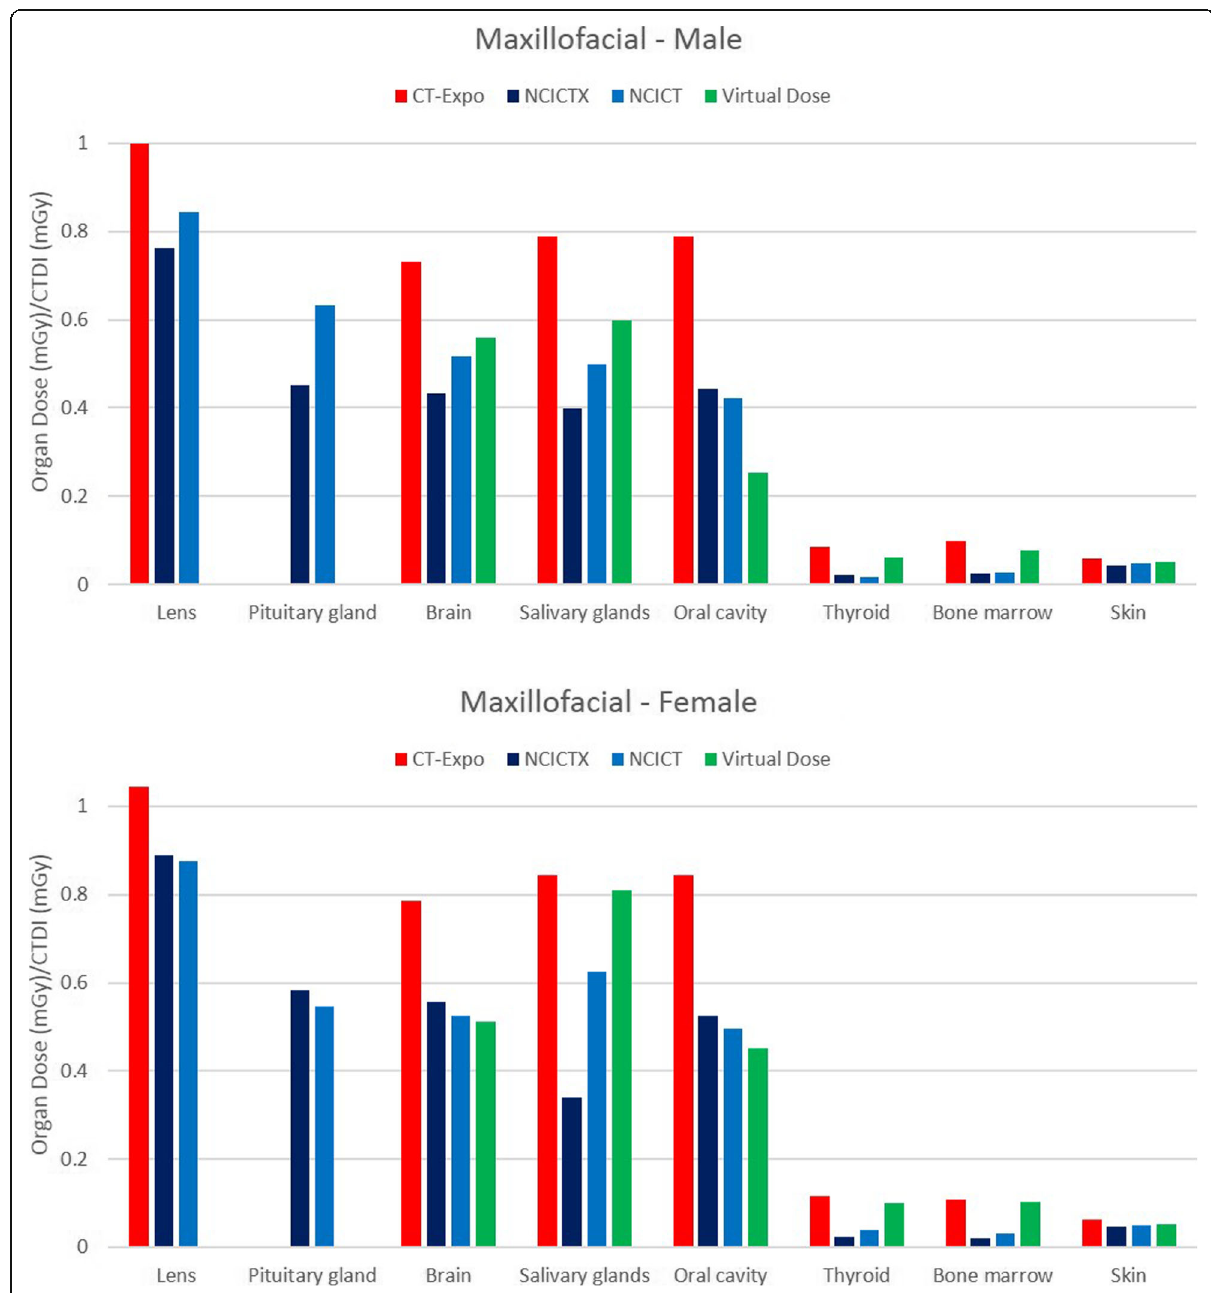
Fig. 3 Organ dose per volume computed tomography dose index (CTDI vol ) unit, obtained simulating the CT maxillofacial protocol with CT-Expo, NCICTX, NCICT, and Virtual Dose, using a male and a female phantom. These values are dose coefficients, obtained as organ dose (mGy) and CTDI vol (mGy) ratio. Pituitary gland and lens are completely irradiated. Only NCICTX and NCICT consider the pituitary gland. Virtual Dose does not consider